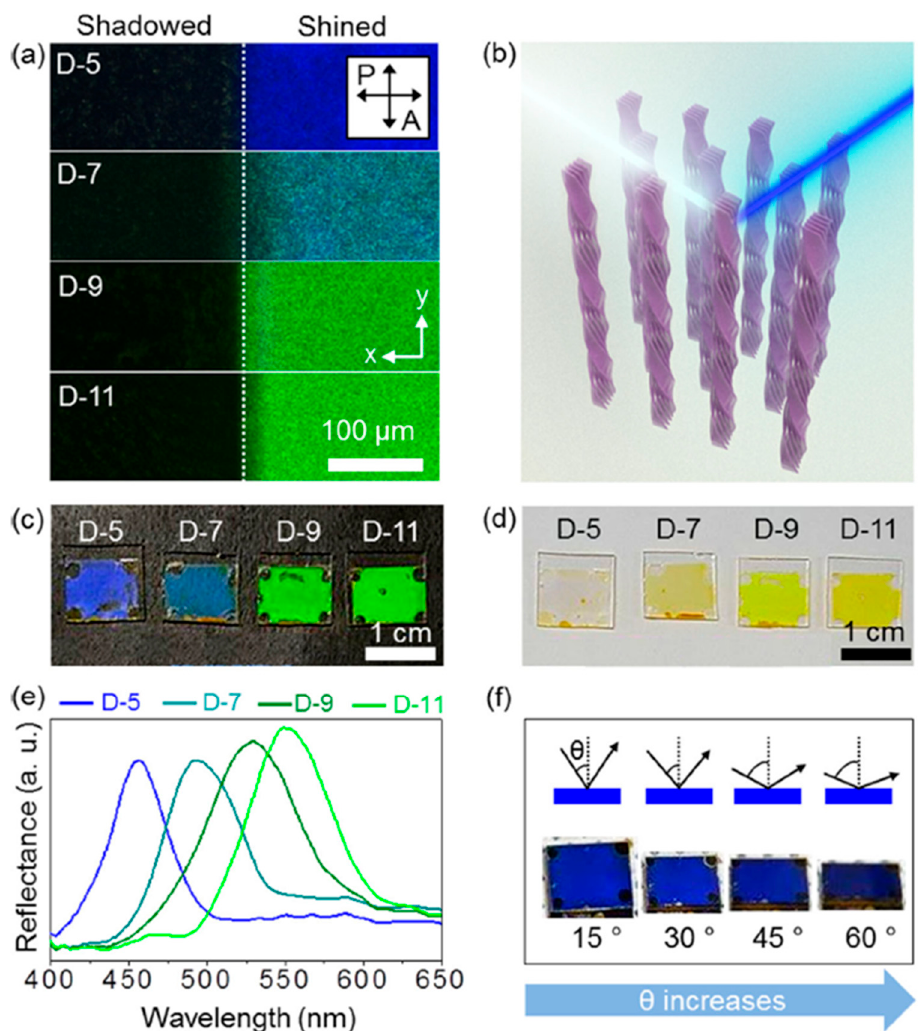
Figure 15. Structural coloration from the uniformly oriented HNF film. ( a ) Reflective POM images of D-n series in their HNF phases. Only the UV-shined area showed the reflection color, and color changes as the linkage length of the dimer (n in D-n) increased. ( b ) Schematic illustration of light reflection of aligned HNFs when subjected to white light. ( c ) HNF films show a vivid reflection color when placed on a black background. ( d ) When they are placed above a white background, yellow chemical colors are mostly observed due to the scattering e ff ect from the background. ( e ) A reflective spectrum of aligned HNF films. ( f ) Photographic images of viewing angle-dependent reflective color changes of D-5 film. Reprinted with permission from [7], Copyright 2019, Springer Nature.